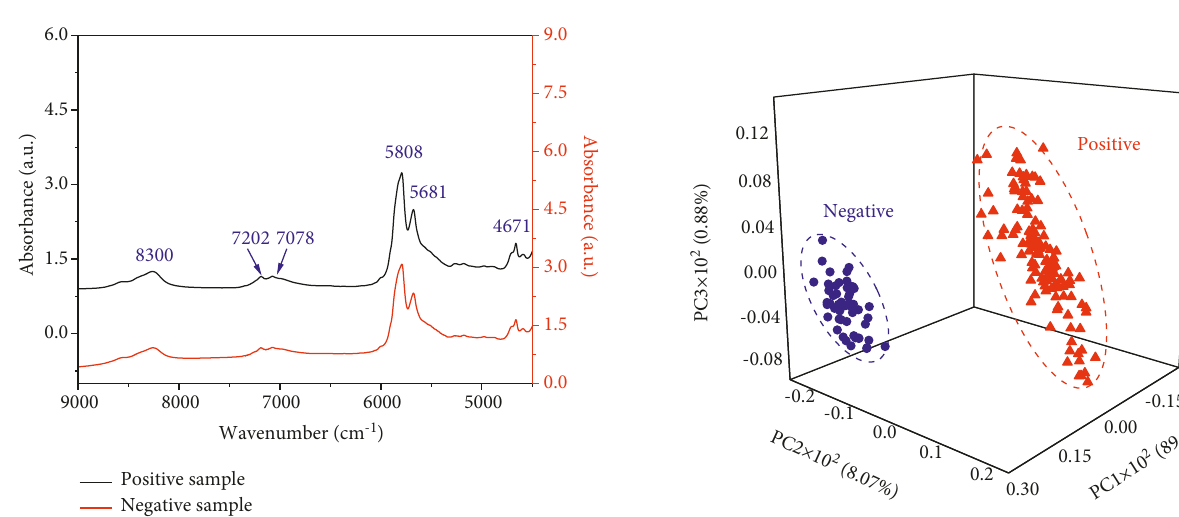
Figure 6: The three-dimensional principal component score of the discriminant model.